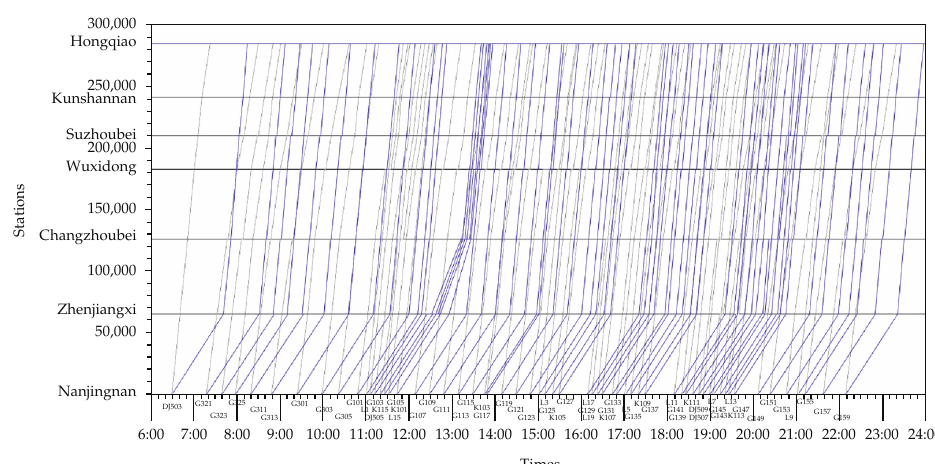
Figure 7: Timetable of speed restriction in one section and one train